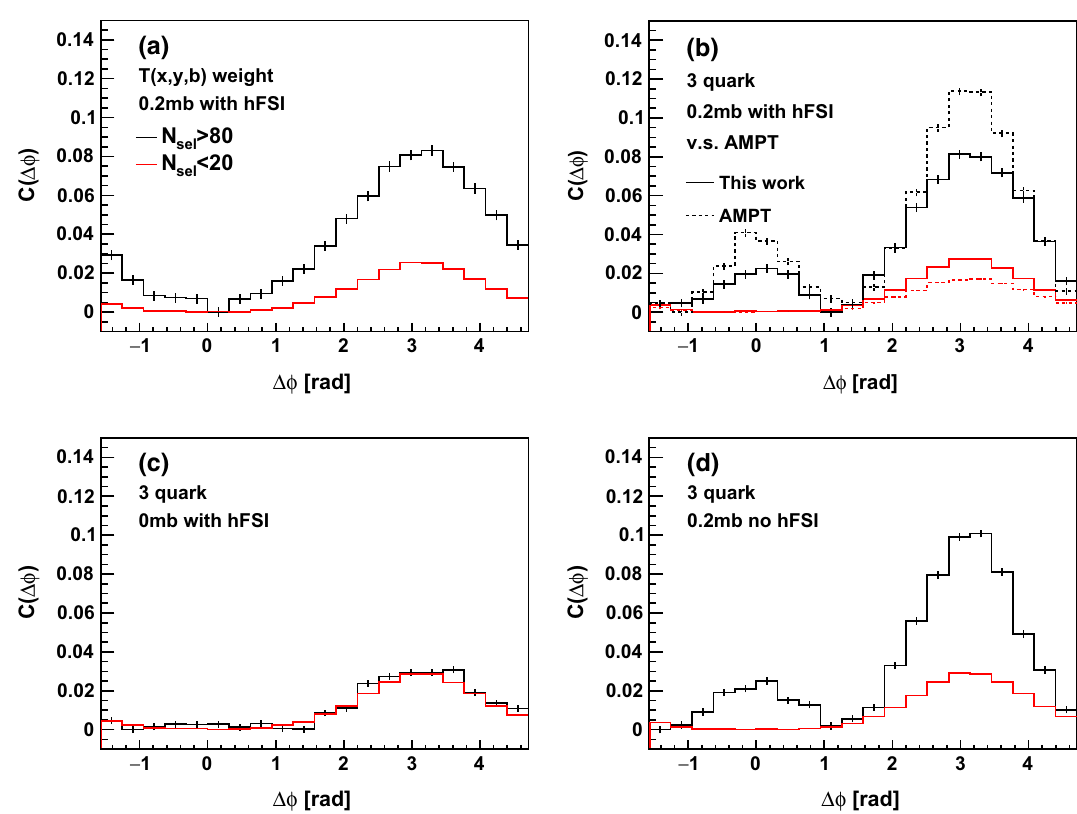
Fig. 11 Two particle correlations with large pseudo-rapidity gap final state effects on the correlation function with only hadron rescatter- | Δη | > 2 and 1 < p < 3 GeV / c in high multiplicity events (black ings ( c ) and parton rescatterings ( d ) are also shown based on the quark T constituent picture. The corresponding results from full AMPT (dashed line) and low multiplicity events (red line) for initial proton geometry line) are shown in ( b ) for comparison with overlap function method ( a ) and quark constituent picture ( b ). The